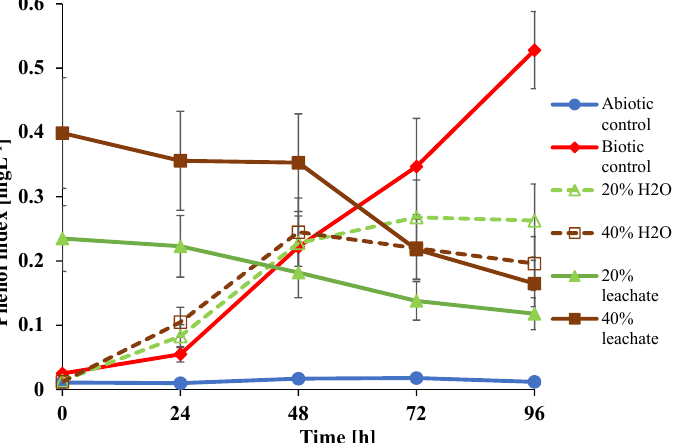
Figure 3. Volatile phenol content during U. isabellina cultures with the addition of 20% and 40% landfill leachate.